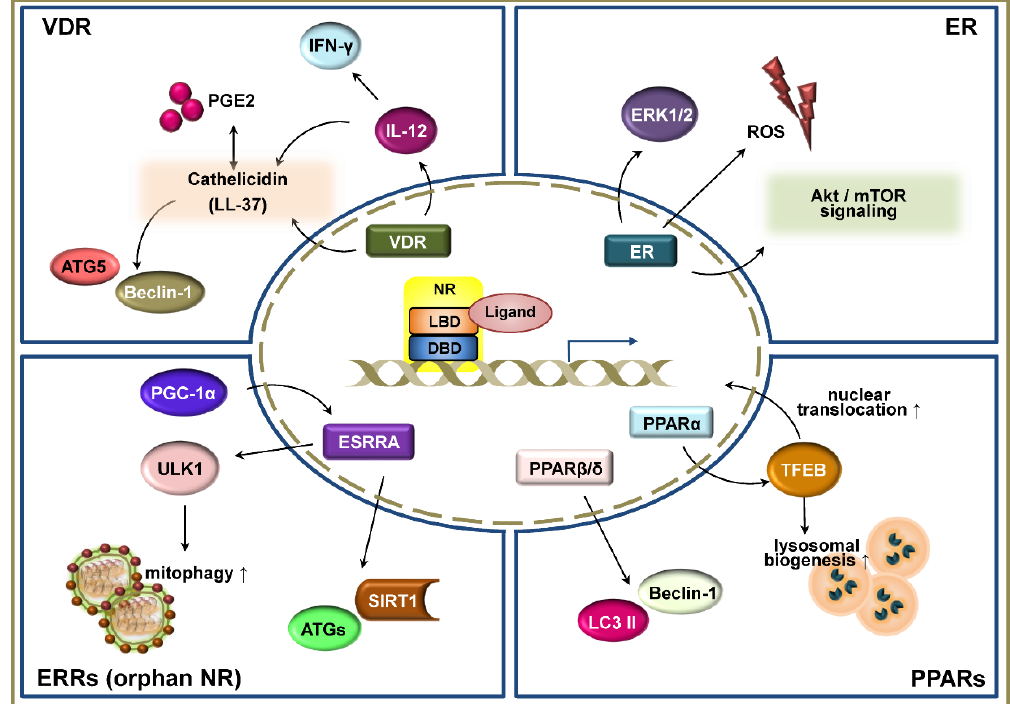
Figure 2. Schematic representation of the signaling pathways of nuclear receptors (NRs) in autophagy-mediated host defense. NRs, including the vitamin D receptor (VDR), estrogen receptor (ER), estrogen-related receptors (ERRs), and peroxisome proliferator-activated receptors (PPARs) have been shown to play critical functions in the regulation of autophagy-mediated host defensive immune responses during infection. These NRs regulate and participate in the autophagic signaling pathways not only at the transcriptional level, but also at the post-transcriptional level. VDR is one of the best characterized NRs related to autophagic function against various infections. It is well-known that VDR signaling increases autophagy activation via the induction of cathelicidin, which is a small cationic antimicrobial peptide. In addition, VDRs functionally link adaptive and innate immune responses by regulating downstream pathways of autophagy. ER activates autophagy by increasing reactive oxygen species (ROS) generation and Akt / mammalian target of rapamycin (mTOR) signaling. ERRs, which are one of the orphan family members of NR, also regulate a variety of cellular responses, including autophagy. The induction of PGC-1 α upregulates the ERR α to promote mitophagy and an antimicrobial e ff ect through sirtuin 1. PPAR α activation leads to the expression of transcription factor EB (TFEB) and its nuclear translocation, resulting in the enhancement of lysosomal biogenesis. PPAR β / δ prevents harmful ER stress by increasing autophagy markers Beclin-1 and LC3 II.